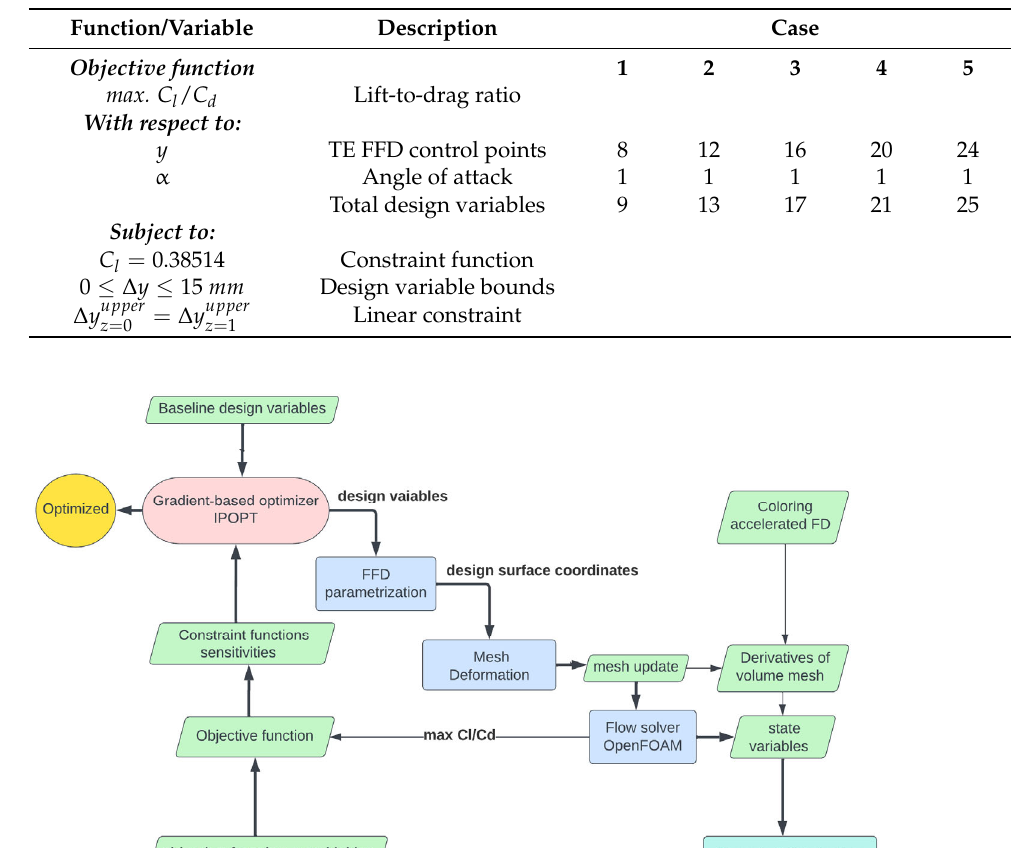
Table 2. Optimization setup for the morphing trailing edge of the UAS-S45.